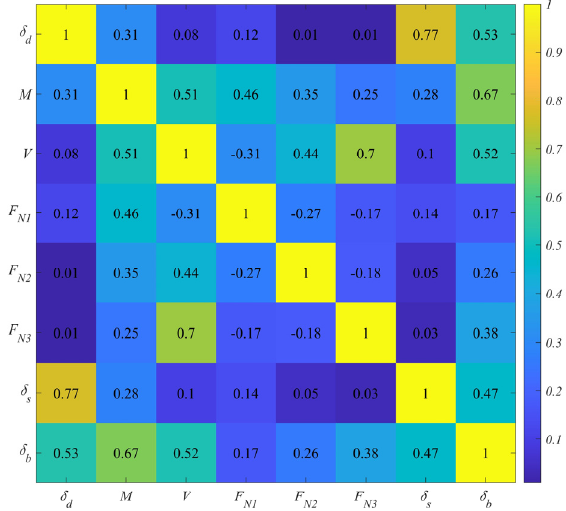
Figure 10. Spearman correlation matrixes of responses (Case 3). Notes: δ d , δ s , δ b are the vector of wall deflection, ground settlement and basal heave, respectively. M, V are the vector of bending moment and shear force of diaphragm wall, respectively. F Ni is the vector of axial force of strut in i th layer.